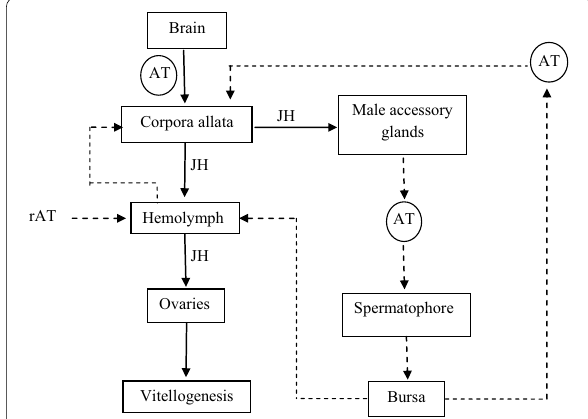
Fig. 6 Possible targets for allatotropin (AT) in Spodoptera litura adults, associated with vitellogenesis. Solid lines represent known pathways, while broken lines are speculative based on information from other species. The known pathway works through some of the brain factors, such as the allatotropin, to induce JH biosynthesis in the corpora allata, and JH, in turn reaching the ovaries via hemolymph, where it regulates the process of vitellogenesis in the females. While in males, the JH synthesized in CA is transferred to the accessory glands. We hypothesize the transfer of AT by means of spermatophore to the bursa of females during copulation (broken line), in turn reaching the CA either directly or via hemolymph, thus, inducing JH biosynthesis. While the recombinant allatotropin injected into hemolymph may induce JH synthesis in the hemolymph or travel to CA and bring about JH synthesis. (Juvenile Hormone: JH; Allatotropin: AT; Recombinant allatotropin: